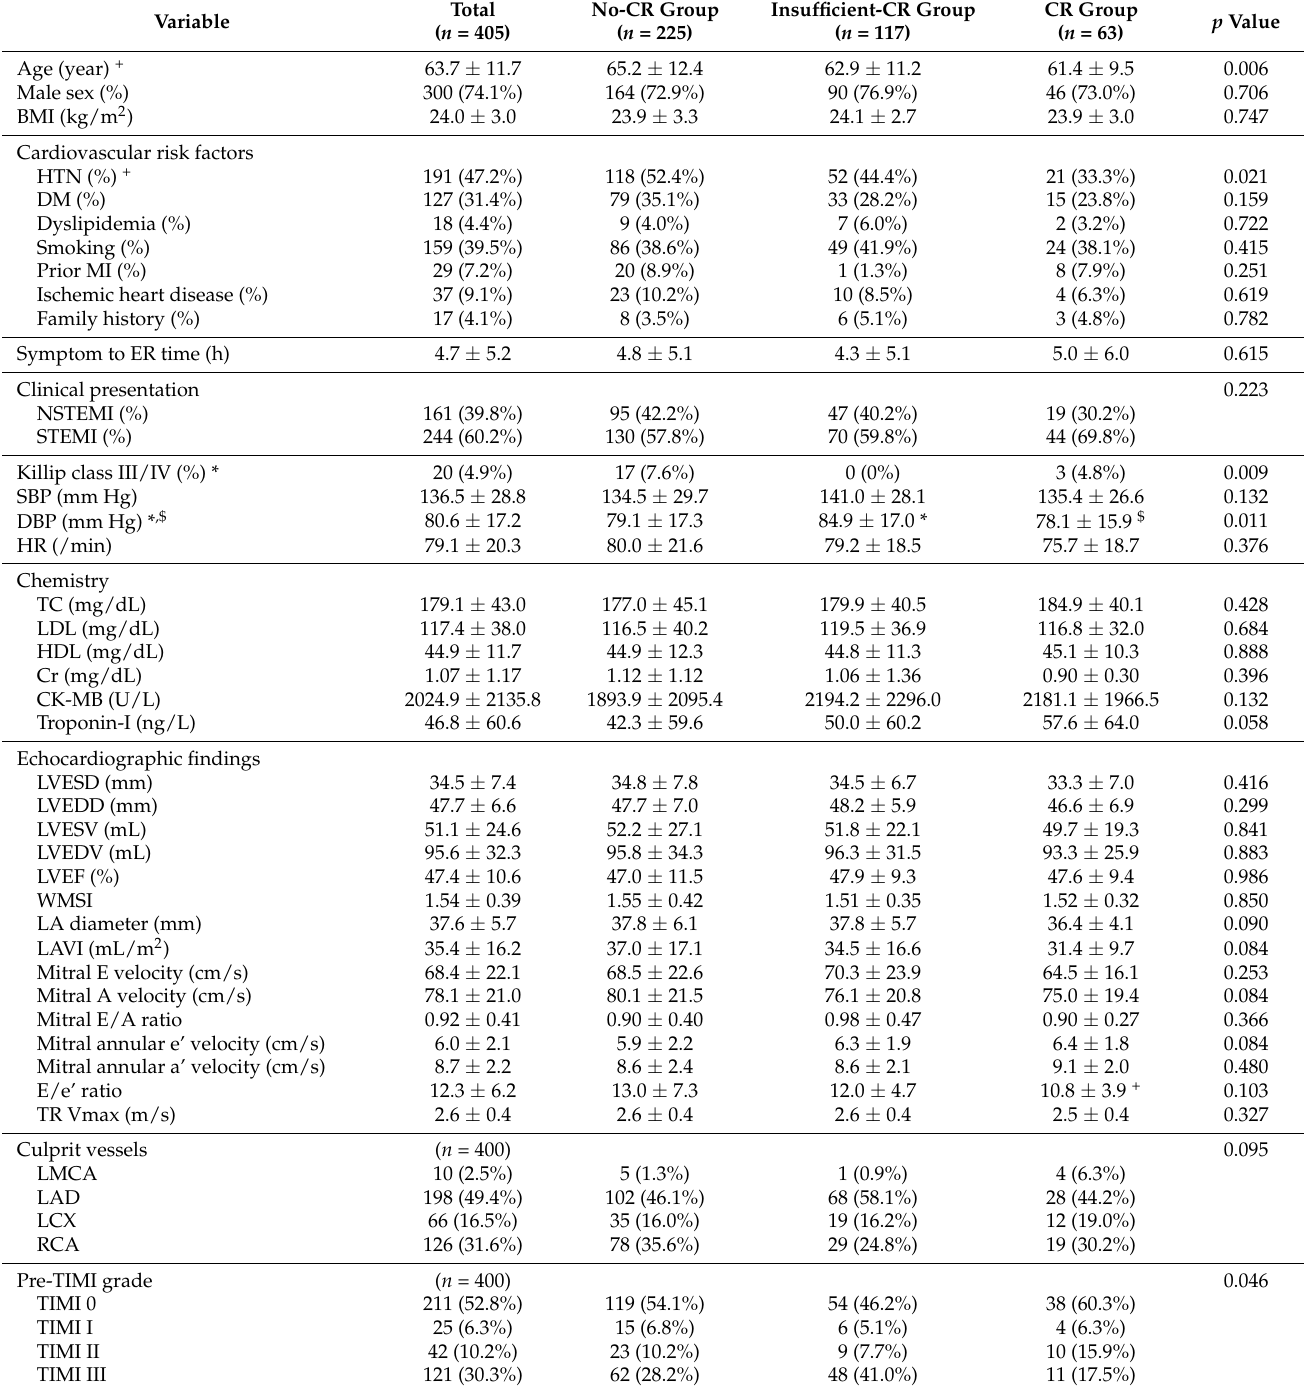
Table 1. Comparison of clinical and echocardiographic parameters according to the presence of cardiac rehabilitation (CR) therapy in discharged